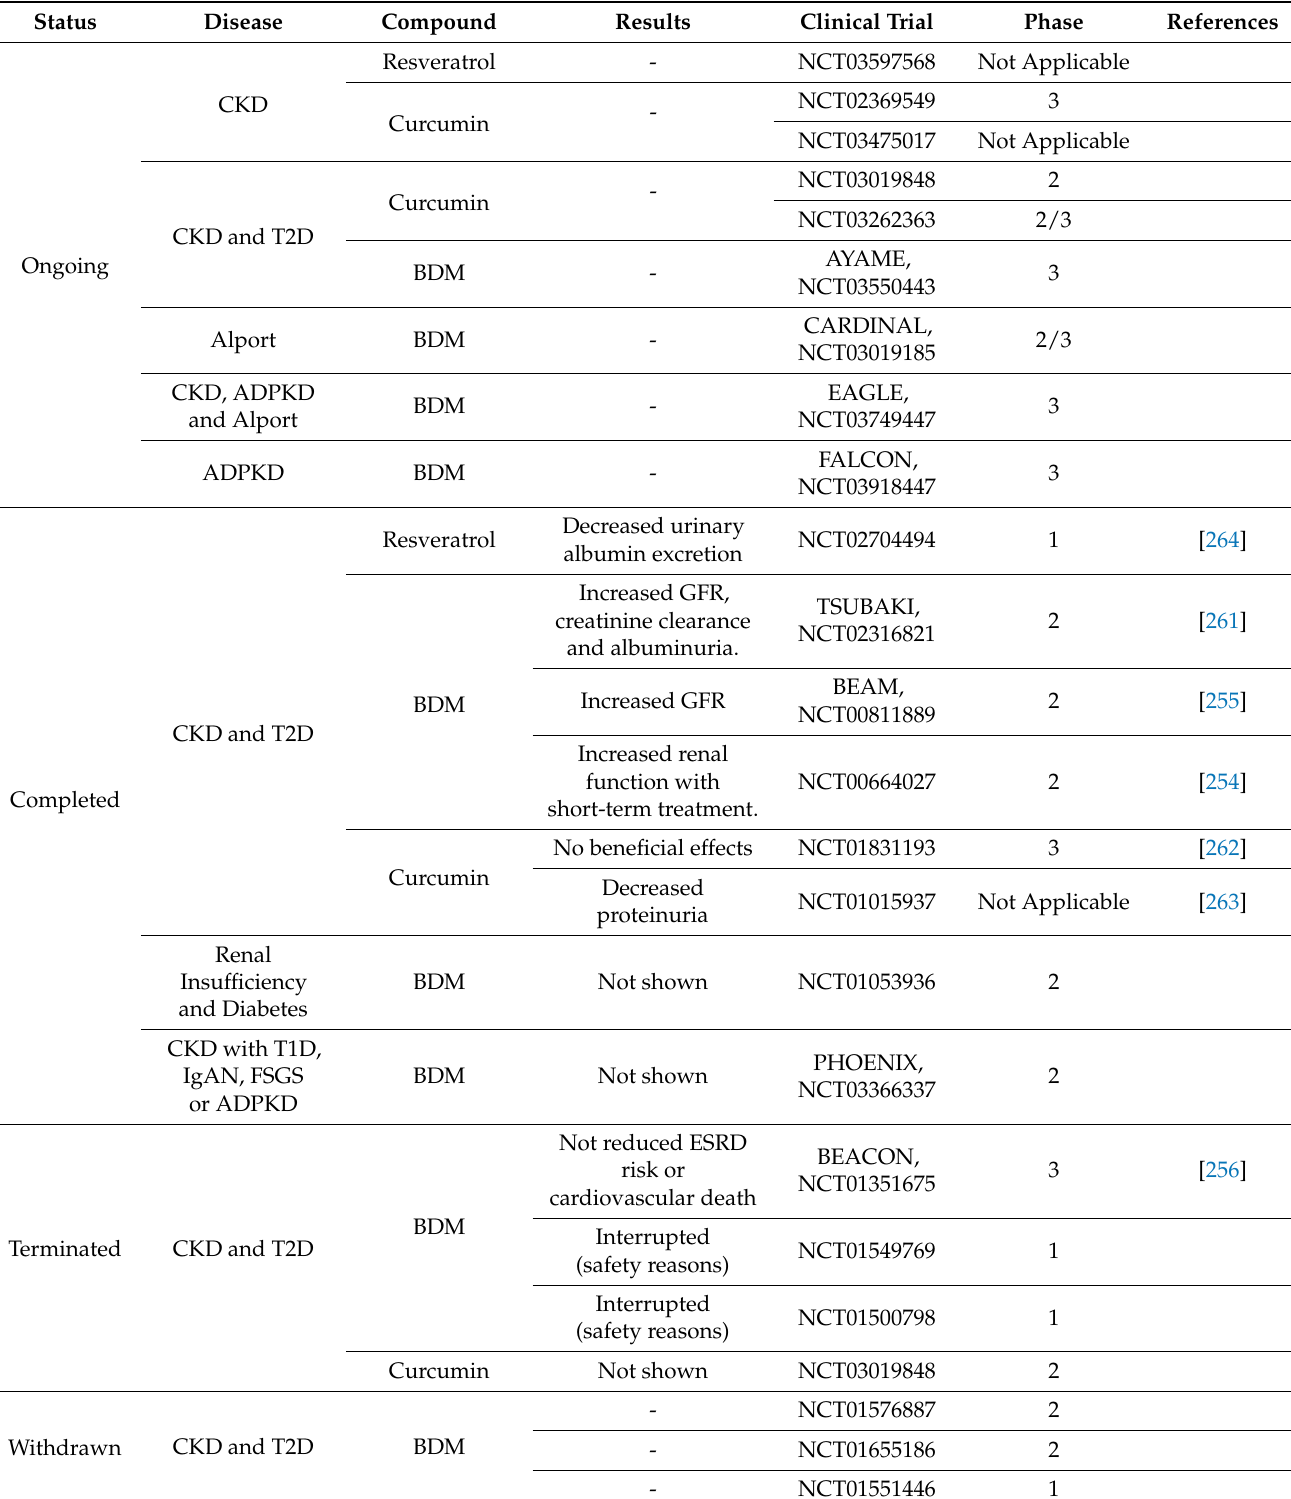
Table 4. Summary of clinical trials with Nrf2 inducers in